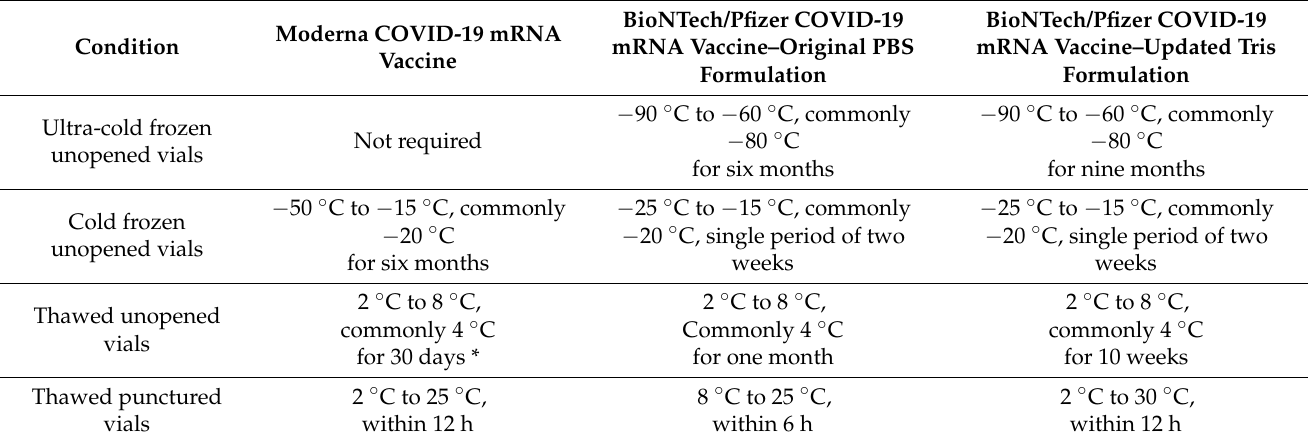
Table 2. Storage and transportation condition comparison for the regulatory-approved COVID-19 mRNA vaccines